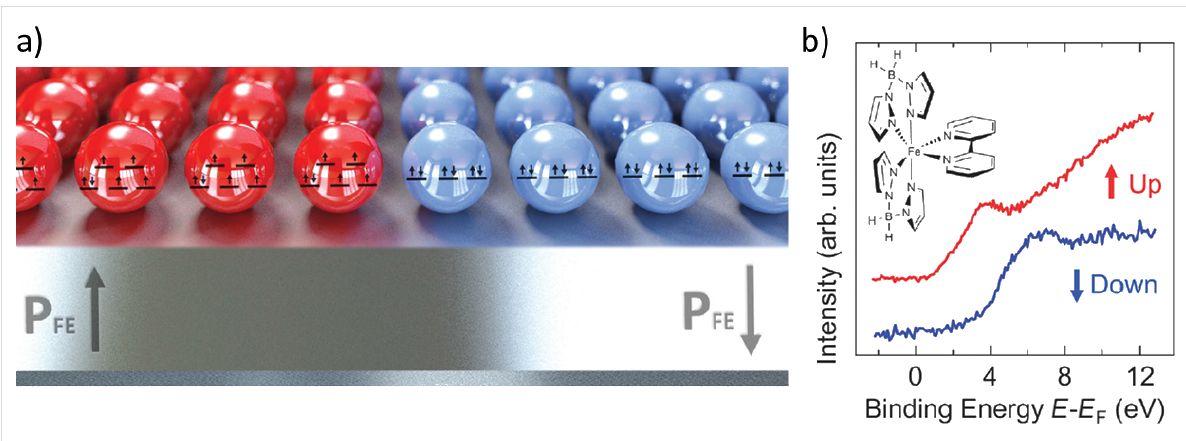
Figure 8: a) Schematic view of the molecular memory proposed by Zhang et al. At low temperatures, the spin state is determined by the polarization of the ferroelectric substrate. If the substrate is poled “up”, the SCO molecules will remain HS; conversely, the SCO molecules will adopt the LS form for a substrate poled “down”. b) Inverse photoemission spectrum at 170 K for a 25 molecule thick layer of [Fe(H 2 B(pz) 2 (bipy)] deposited on PVDF–TrFE poled “up” (red) and “down” (blue). Each spectrum corresponds to the characteristic signature of the complex in the HS and LS form, res- pectively. Adapted with permission from [35], copyright 2014 The Royal Society of